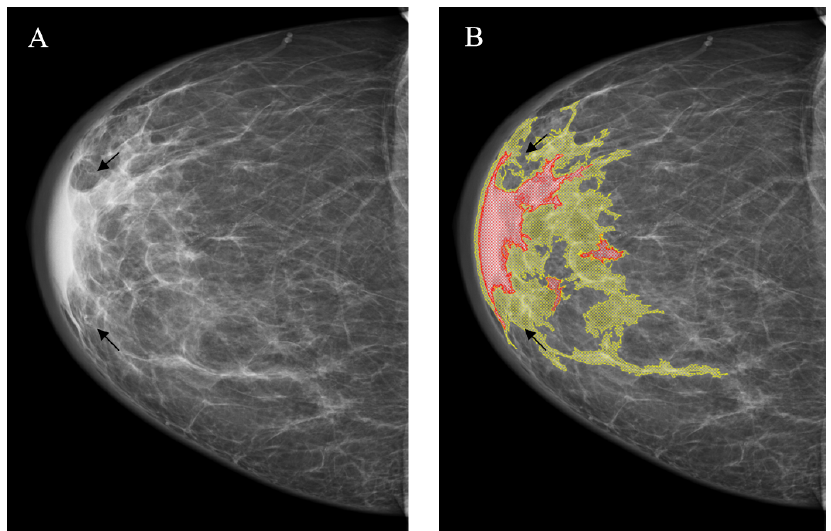
Figure 8. Asymmetric density (arrows). ( A ): Source image; ( B ): NCA outcome. The YOLOv4 did not mark the lesion. mark the lesion.